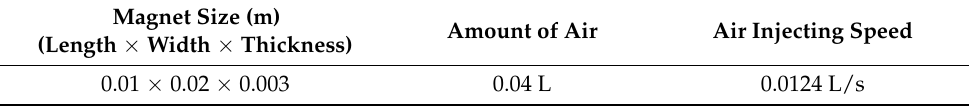
Table 3. Conditions for the robot used in the changing